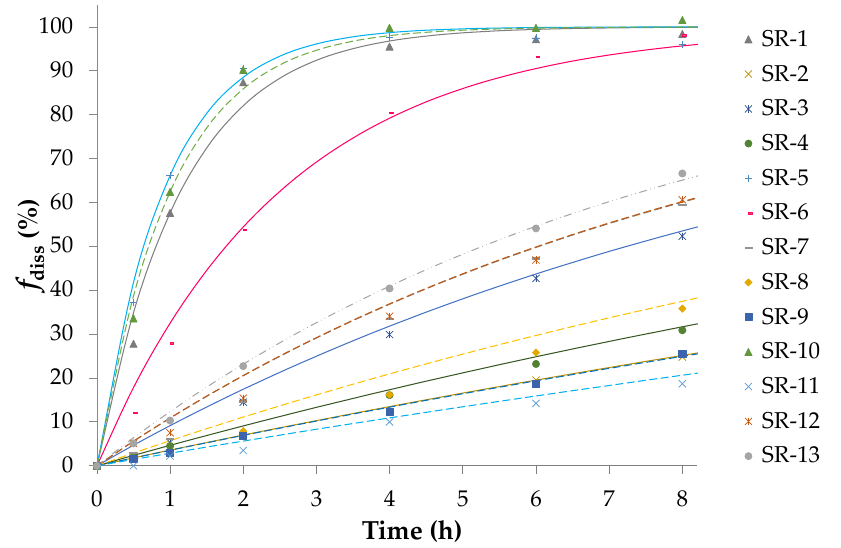
Figure 2. Dissolution tests of sobrerol SR pellets and the first-order fitting curves. The first-order model could most favorably explain the drug release of SR pellets in the 0–8-h interval.